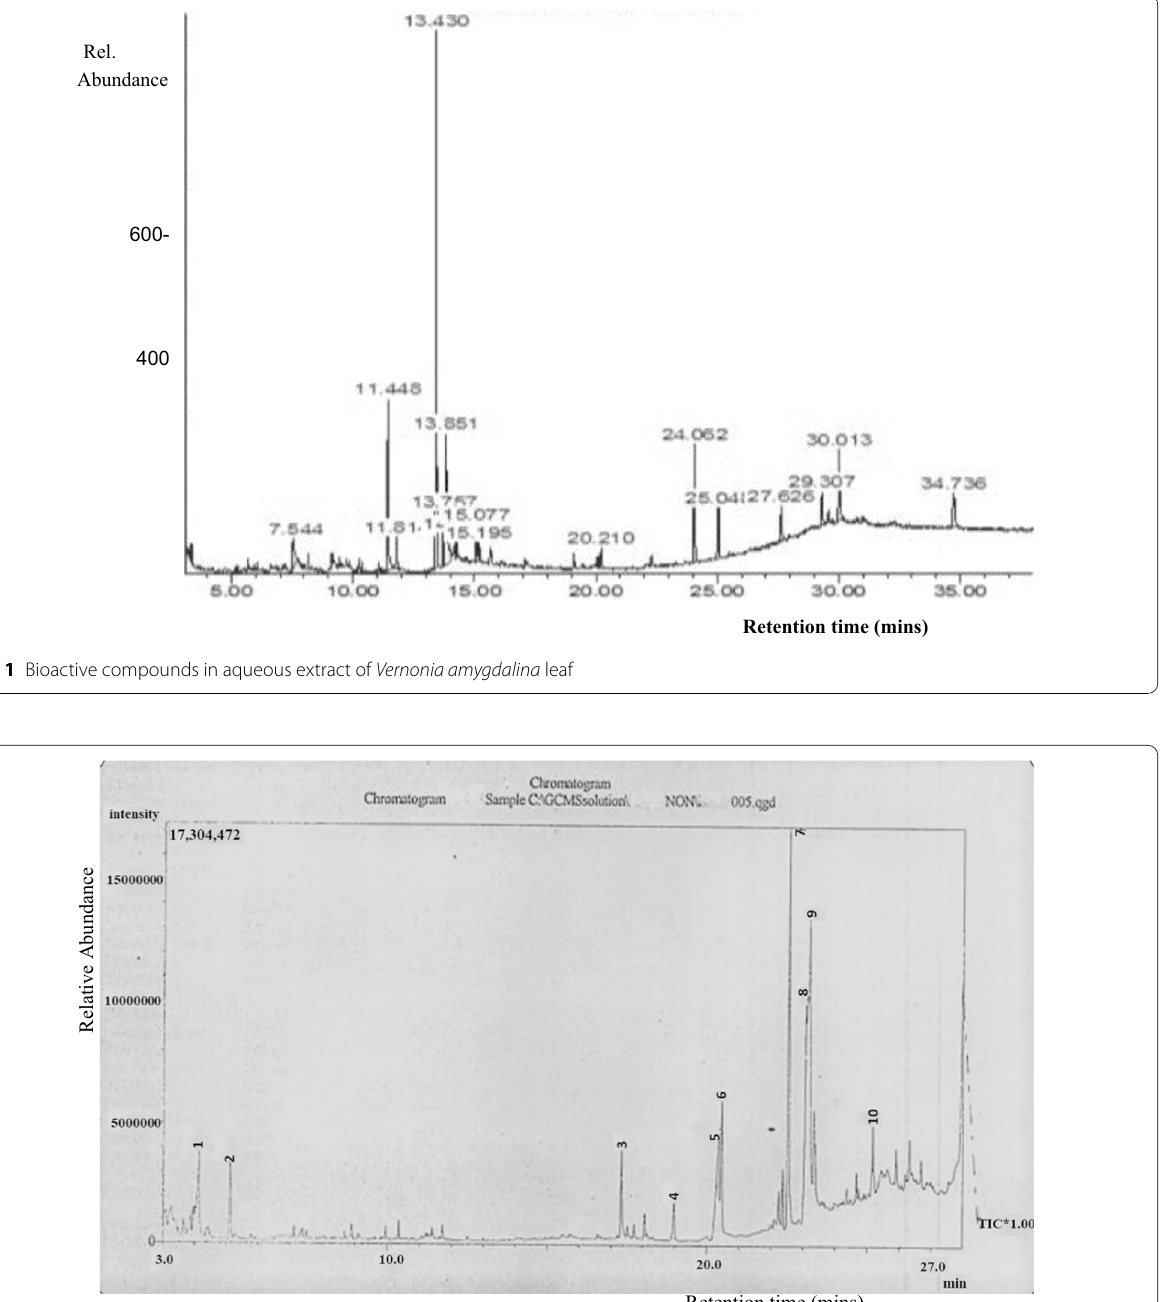
Minimum inhibitory concentration of ethanoic and aqueous extracts of Vernonia amygdalina leaf The table represents the minimum concentration at which the extracts inhibited the bacterial isolates with no isolate strain remaining. The MIC values obtained on